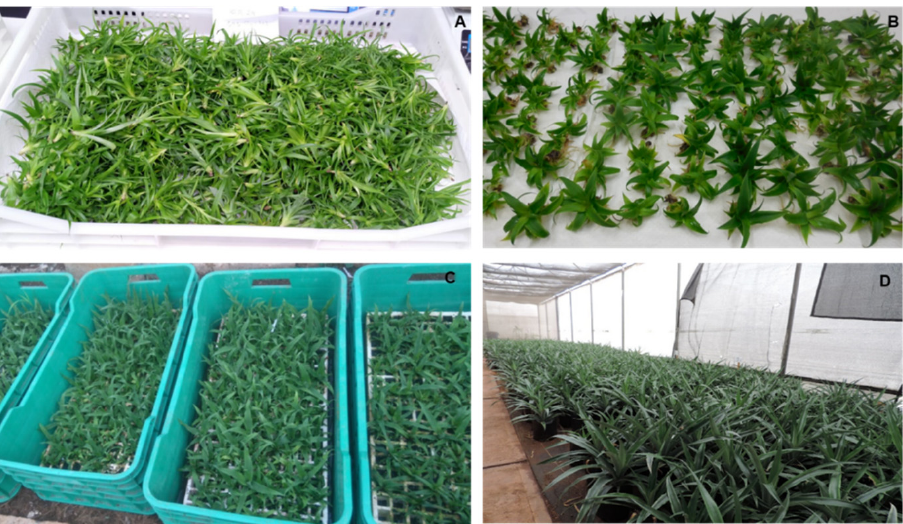
Figure 6. ( A , B ) Isolation of in vitro plantlets obtained in M3 and M7 media and developed and elongated in M4 medium. ( C ) Acclimatization in trays with substrate in a greenhouse. ( D ) Pineapple plants regenerated in vitro and ready to be transferred to the field after 20 weeks in polyethylene